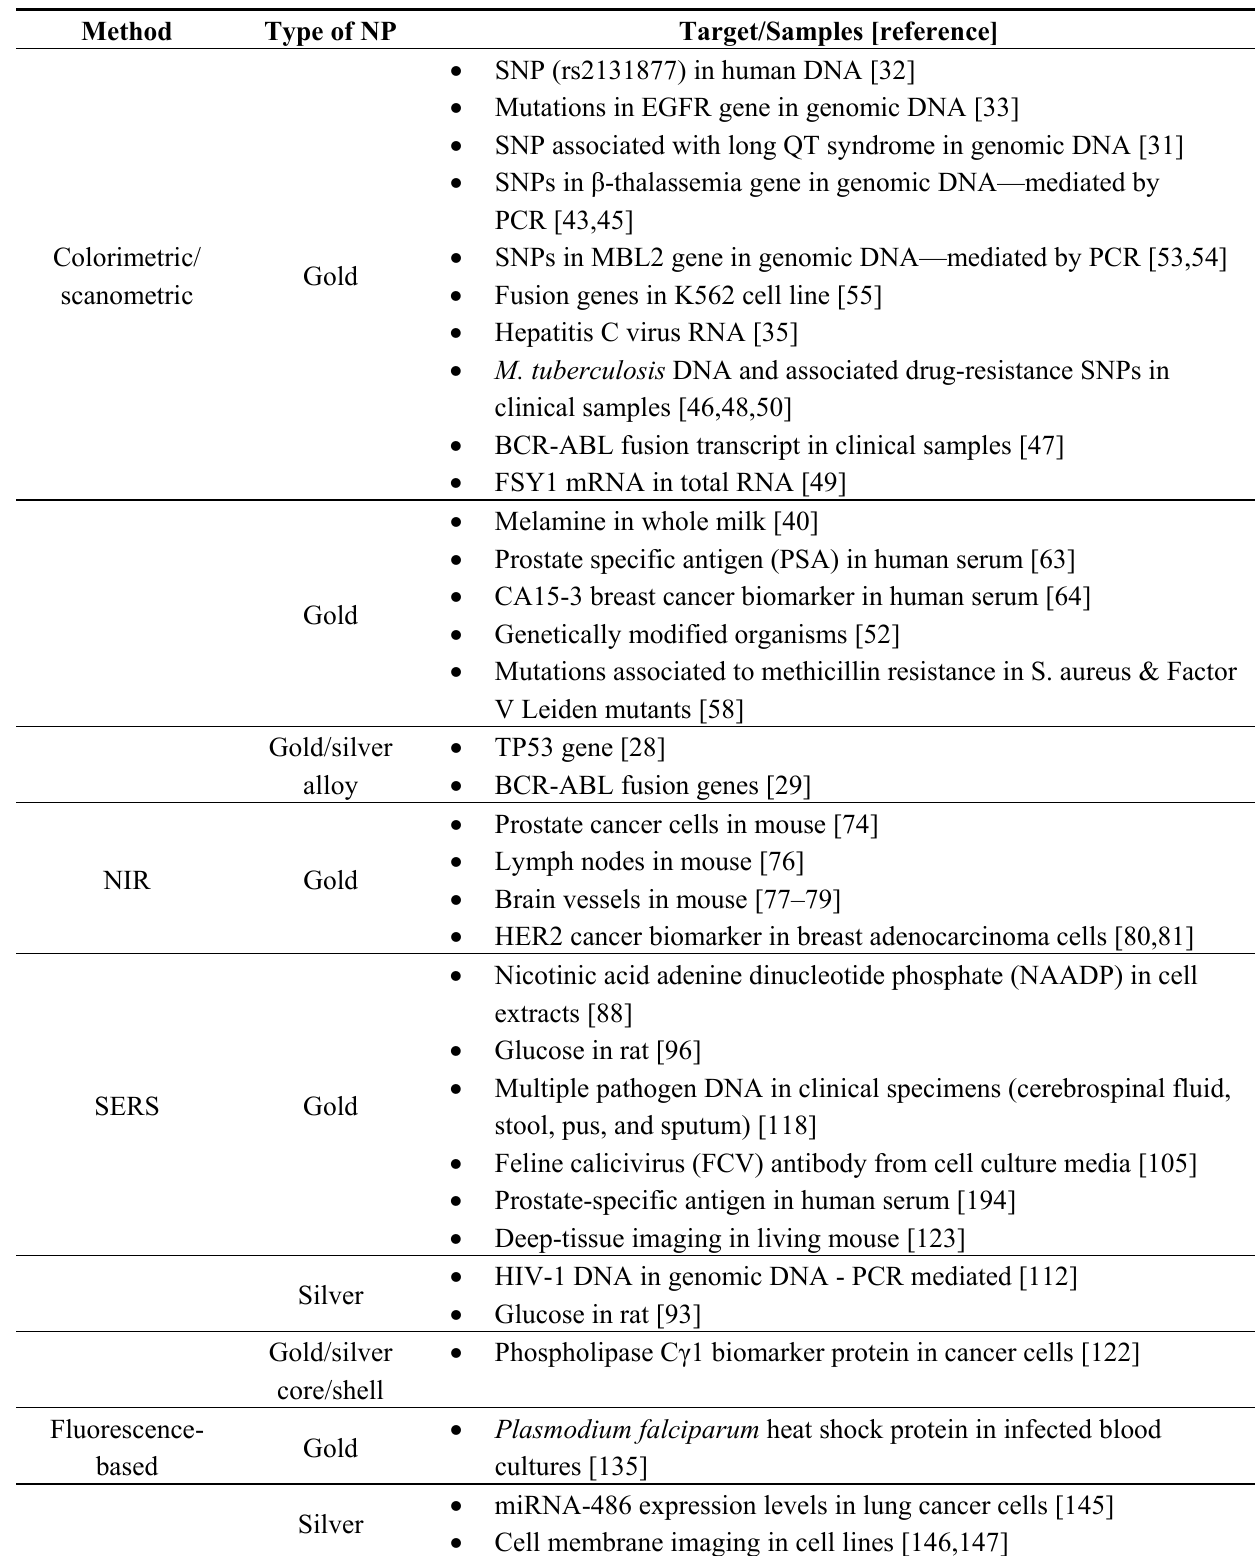
Table 2. Summary of real biological samples tested with noble metal NP-based biosensors according to the type of NP and explored methodology